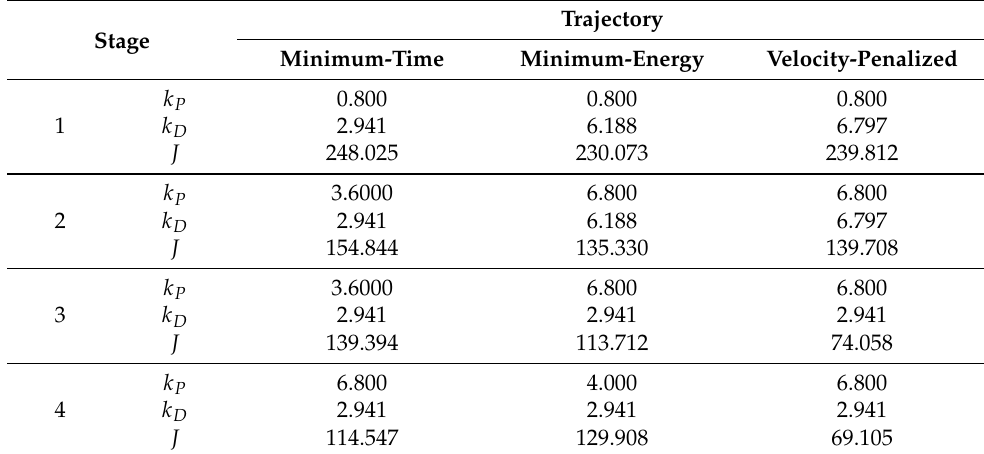
Table 1. Optimization of landing on the basis of IMU readings—10s experiment.